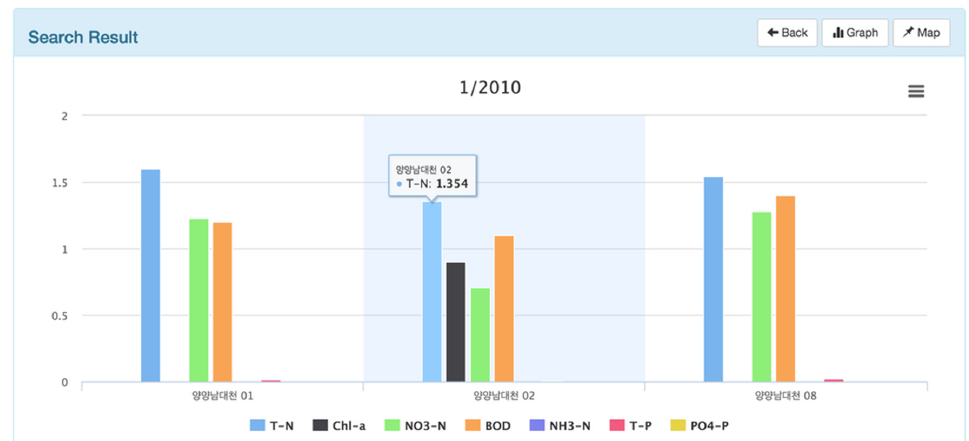
Figure 14. Observation data in the chart window.